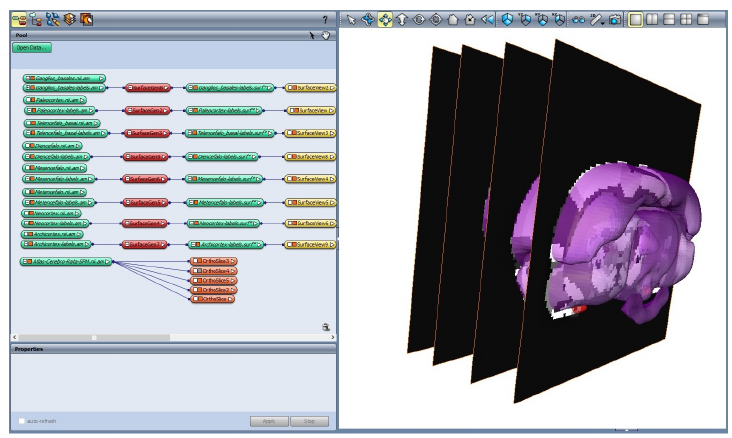
Figure 3. Data labeling in Amira 3D software. A set of slices is displayed, which belong to the Neocortex region, from the selected dataset. This functionality selects in each of the slices the regions with the same gray